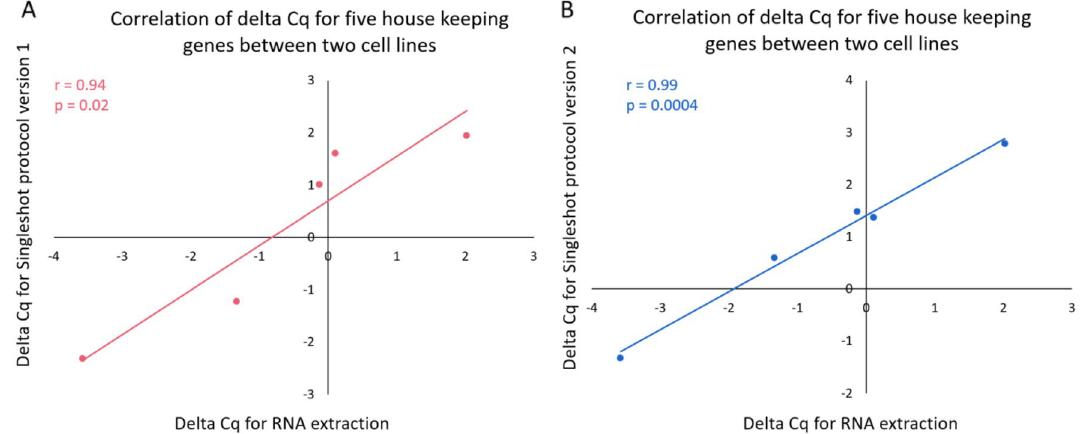
Figure 3. Correlation between delta Cq values (A549-BEAS-2B) from extracted RNA and lysate for both the version 1 and 2 lysis protocols in two different cell lines (BEAS-2B ( A ) and A549 ( B )).